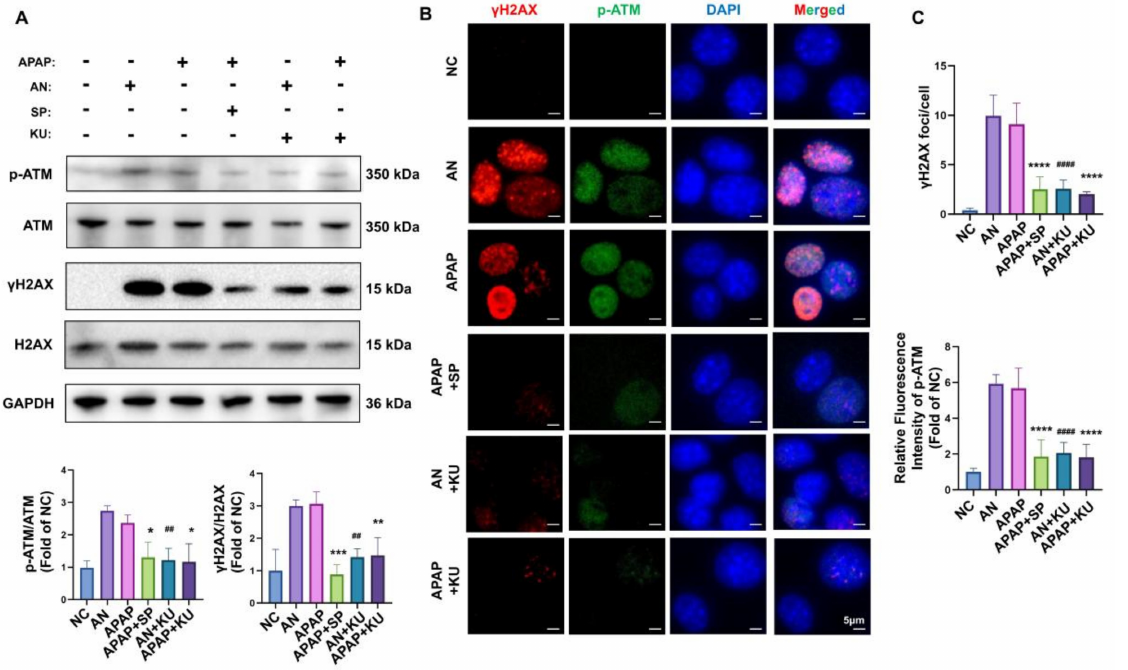
Figure 7. APAP-induced ATM retrograde pathway can be inhibited by inactivating JNK in AML12 cells. ( A ) Immunoblots and quantitative histograms showing the results of Western blotting analysis for the expression of p-ATM, ATM, γ H2AX, and H2AX proteins. ( B ) Representative images showing the immunofluorescence staining for γ H2AX (red) and p-ATM (green) among different groups. ( C ) The number of γ H2AX foci per nucleus was quantitated using ImageJ (Fiji). In each sample, at least 100 nuclei cells were scored. The expression of p-ATM was quantified by measuring the mean gray value. Data are presented as the mean ± SD; n = 3; * p < 0.05, ** p < 0.01, *** p < 0.001 and **** p < 0.0001 vs. APAP group; ## p < 0.01 and #### p < 0.0001 vs. AN group. AN: anisomycin; SP: SP600125; KU: